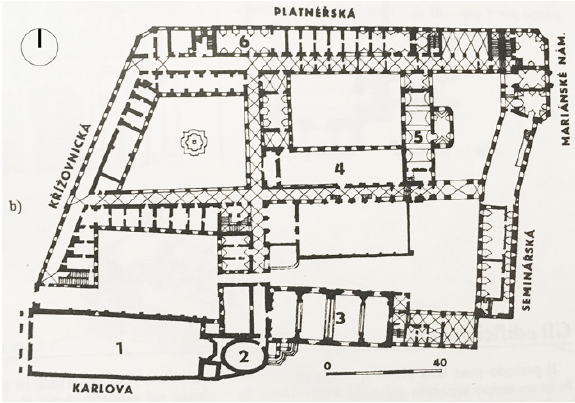
Figure 3. The Klementinum complex, room no. 4 refers to the